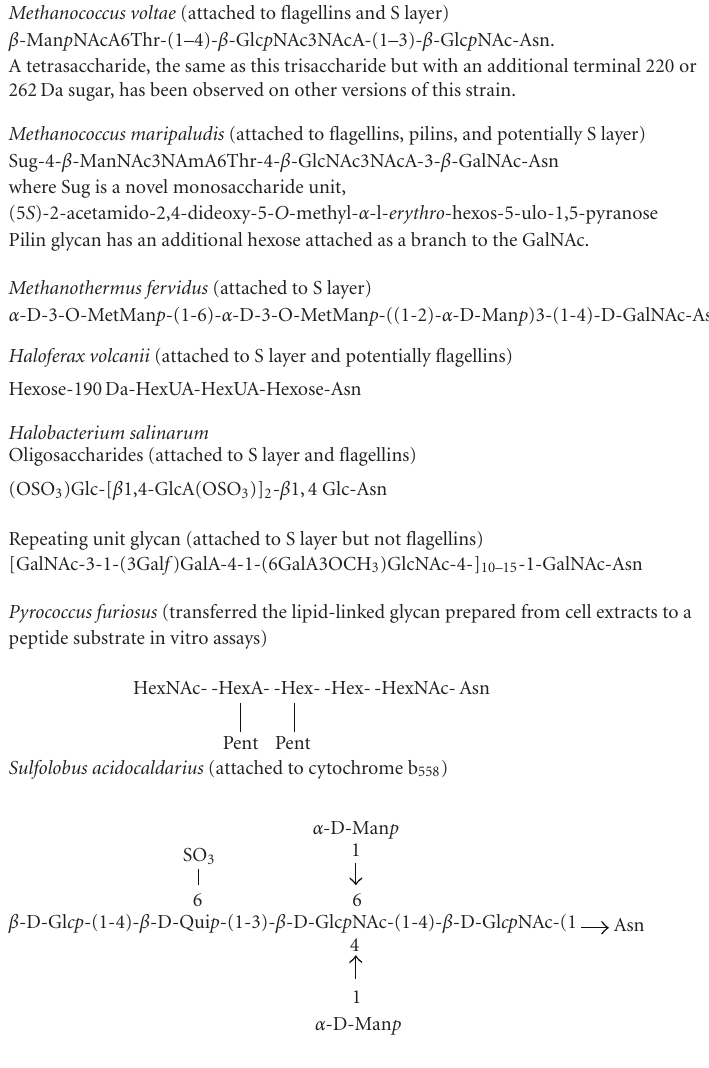
Figure 2: Structures of N-linked glycans in various